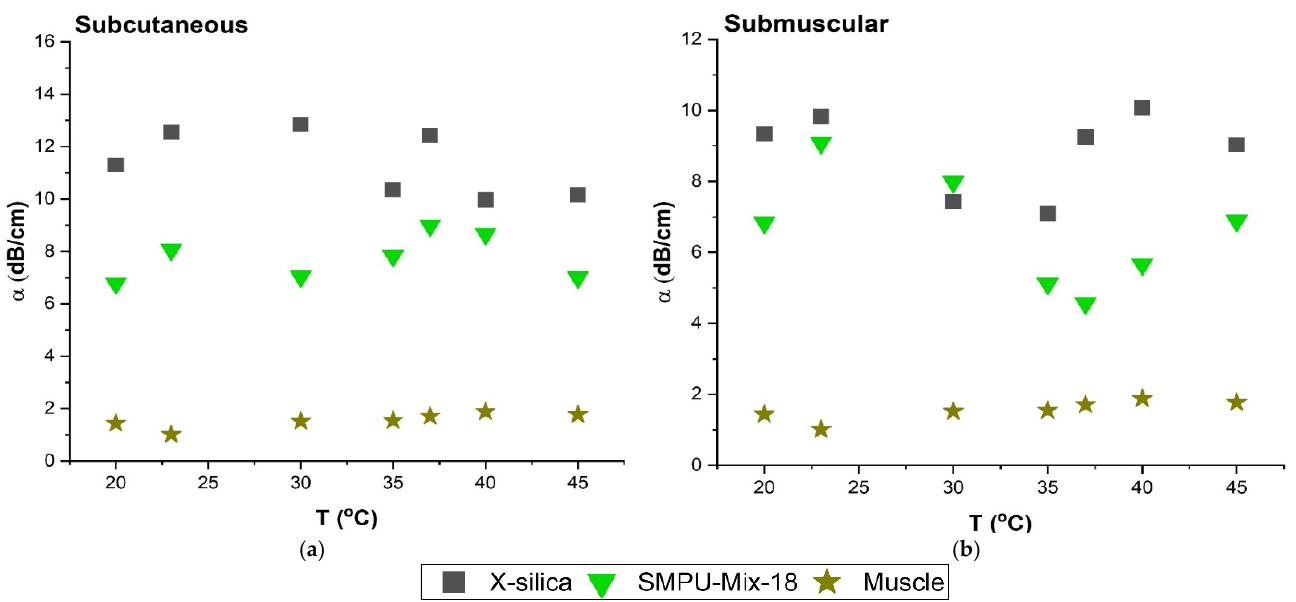
Figure 6. Comparison of attenuation coefficient ( α ) at temperature range of 20–45 °C at 6.5 MHz. ( a ) α in SC region ( b ) α in SM region. Temperature range is consistent with small fluctuations.